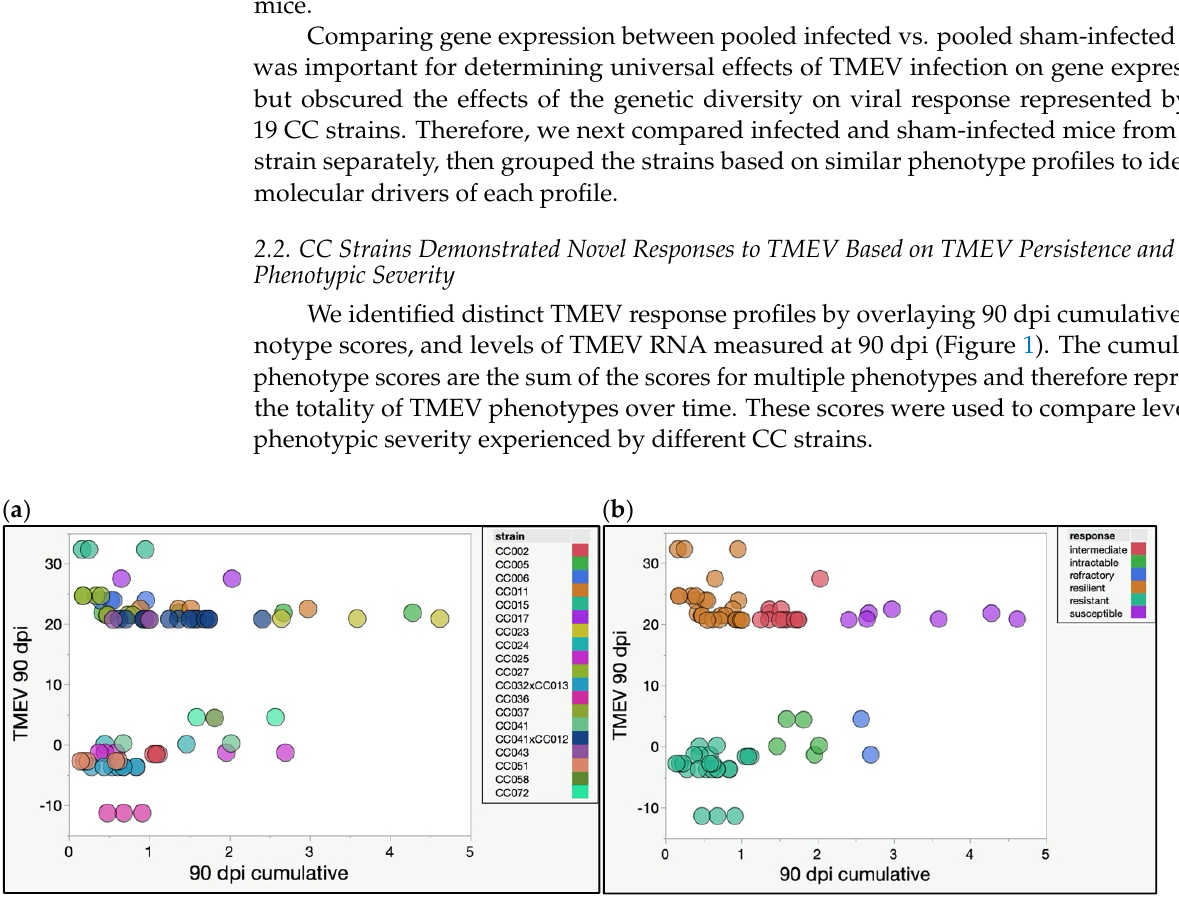
Figure 1. The 90 dpi cumulative scores (cumulative frequencies of hunching, delayed righting reflex, paresis, paralysis, clonus, ruffling, and encephalitis observed over 90 dpi, as described previously [23]) and TMEV RNA levels (shown as log2FoldChange values) at 90 dpi were plotted with different colors for each CC strain ( a ) or response category ( b ).